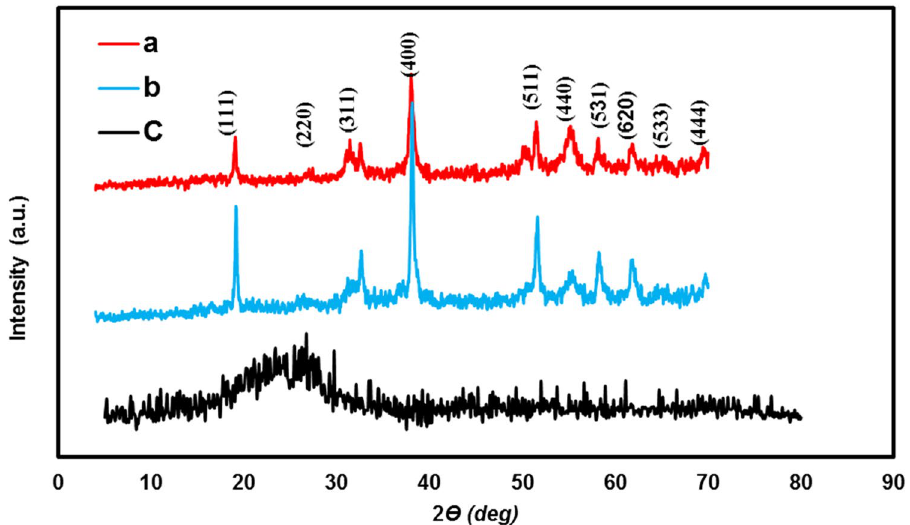
Figure 4. ( a ) XRD patterns of NiCo 2 S 4 , ( b ) NiCo 2 S 4 @PPy and, ( c )